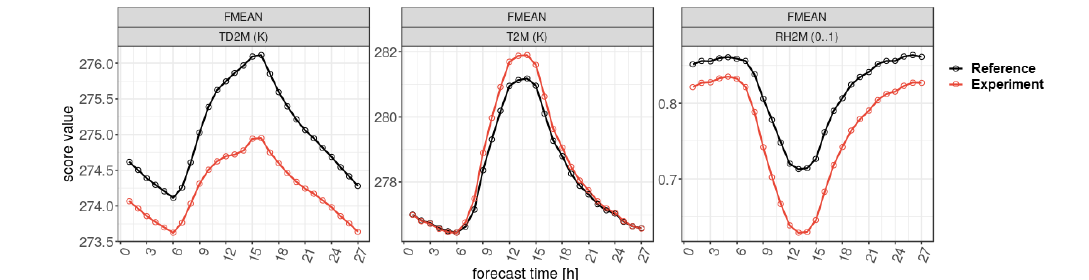
Figure 11. Domain-averaged diurnal cycles of the dew point temperature (TD2M, left panel), atmospheric temperature (T2M, central panel), and relative humidity (RH2M, right panel), all at 2 m above ground, averaged over the whole experimental period from 11 February to 25 March 2019. The COSMO reference version is depicted in black, the experiment in red.